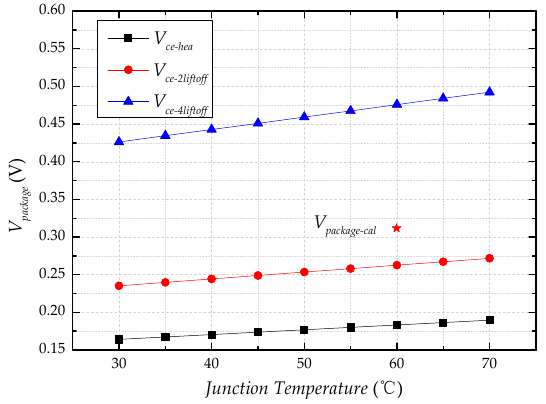
Figure 10. Package voltage at different junction temperature ( I c = 75 A).